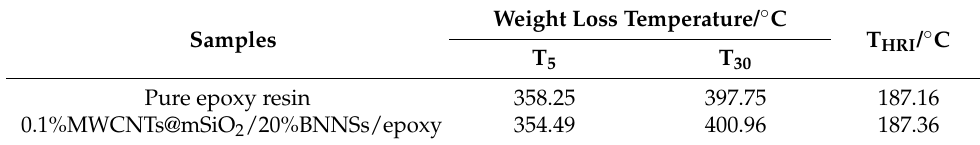
Figure 5. ( a ) TGA curves, ( b ) loss factor curves, and ( c ) storage modulus of the epoxy and BNNSs/MWCNTs@mSiO 2 /epoxy composite at 0.1 wt% loading of MWCNTs@mSiO 2 as a function of temperature. Table 1. Characteristic thermal data of BNNSs/MWCNTs@mSiO 2 /epoxy nanocomposites.